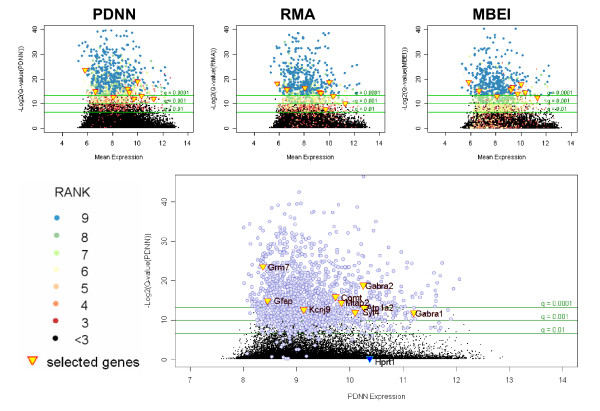
Distribution of ranks according to the three methods of array pre-processing (PDNN, RMA and MBEI). Significance of inter-strain differences is presented as a plot of logarithm of q-value versus expression level. Particular ranks are marked with colour as indicated on the left. Significance steps for ranks are marked with green horizontal lines. 1528 significant probe-sets are presented below as dots marked with light blue. Additionally, selected for qPCR genes were marked with yellow triangles with gene symbols (Atp1a2 – 1455136_at, Comt – 1418701_at, Gabra1 – 1436889_a, Gabra2 – 1455444_a, Grm7 – 1459532_at, Kcnj9 – 1450712_at, Syt4 – 1415844_at, Gfap – 1440142_s_at, Mtap2 – 1440699_at, Hprt1 – 1448736_a_at).